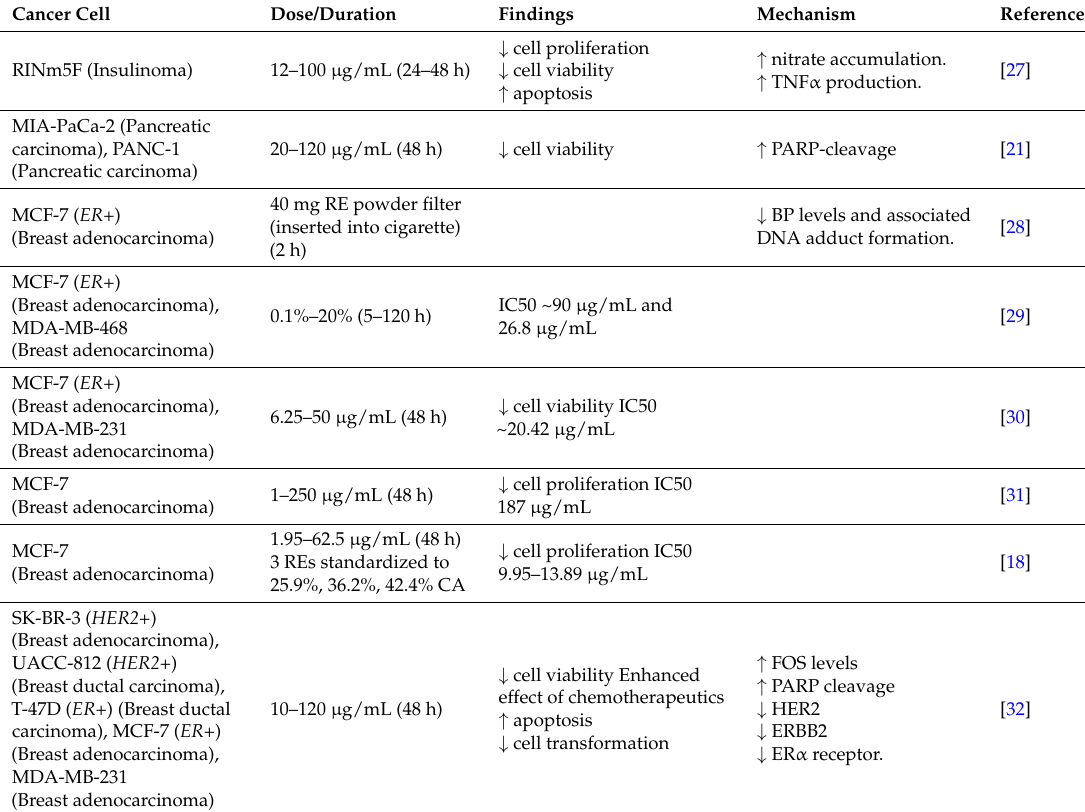
Table 2. Anticancer effects of Rosemary Extract (RE). In vitro studies: pancreatic and breast cancer. Cancer Cell